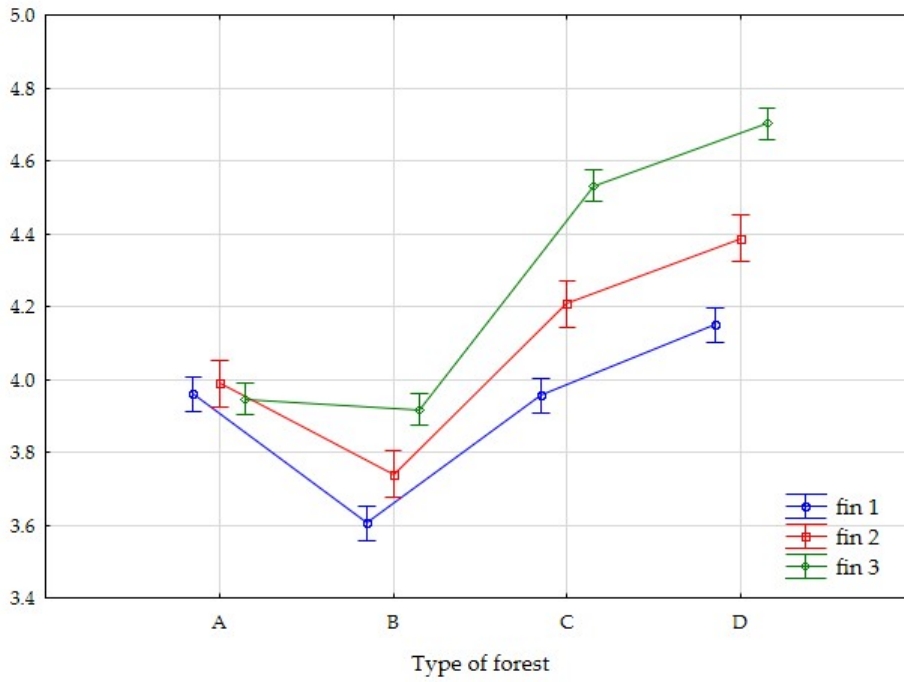
Figure 4. Correlation between forest development level and WTP for it. Table 6. Correlations between forest development levels and willingness to finance them (U Mann–Whitney test for pairs of forests).